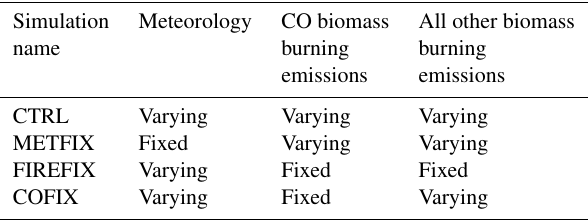
Table 1. Details of TOMCAT model simulations. All simulations are run for